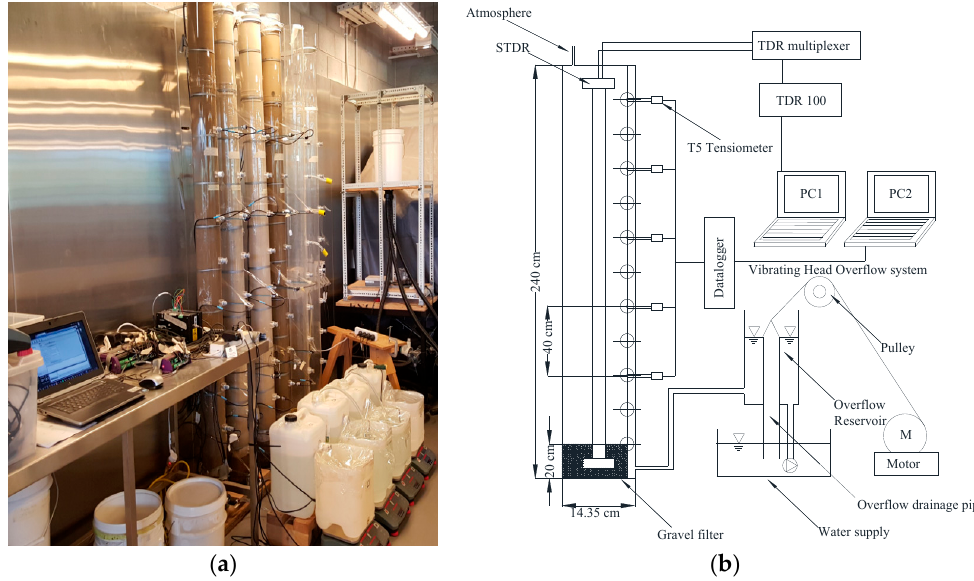
Figure 7. k unsat measurement using transient flow experiments: ( a ) the soil column tests setup; ( b ) an illustration of soil column tests, reprinted from Ref.